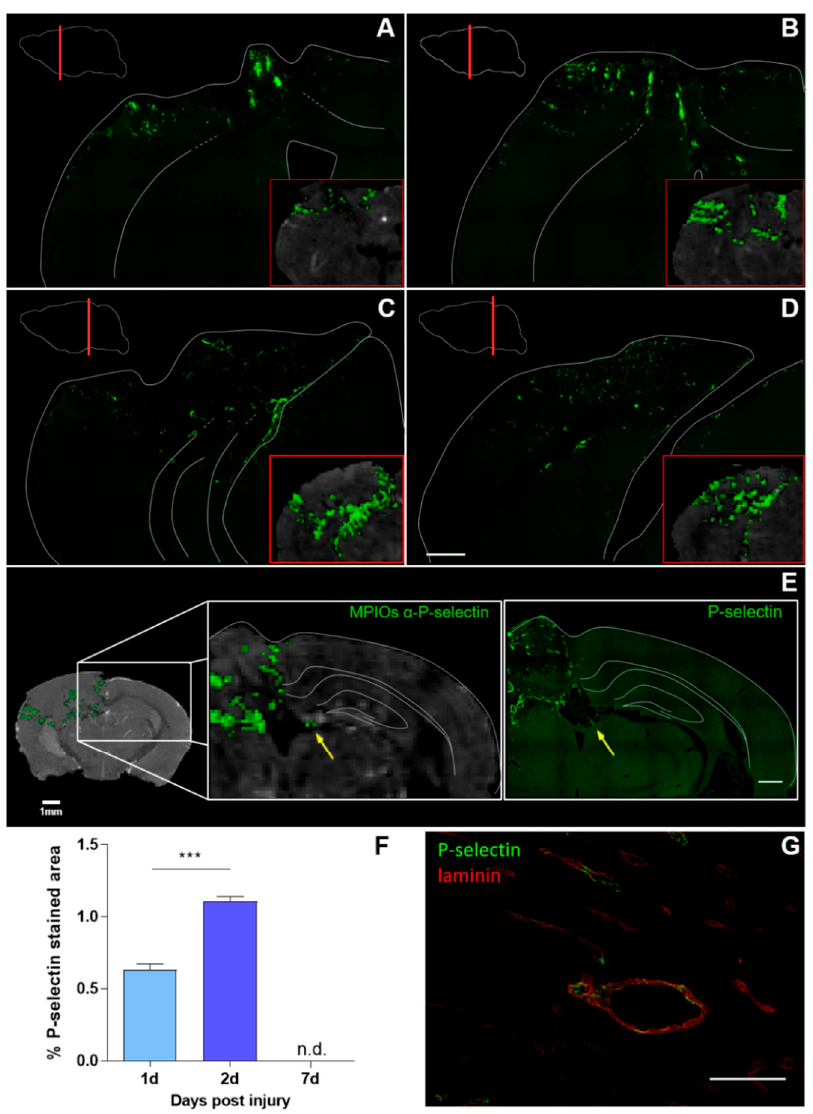
Figure 3. P-selectin signals by MRI and immunofluorescence. ( A – D ) Representative IF P-selectin stained coronal sections − 0.2, − 0.6, − 2.4 and 3.2 from bregma and corresponding MRI slices (insert as red boxes) two days post-injury. Scale bar 500 µ m. A sketch of the main structures of each brain slice was superimposed on the IF image to facilitate the reading. Data indicate a coherent spatial distribution of P-selectin signal with higher percentage of stained area detected by MRI than with IF. ( E ) Qualitative images showing correspondence between MPIOs- α -P-selectin marked volume assessed by MRI in contralateral hemisphere, and P-selectin IF. Here, the choroid plexus was the only structure ever positive for P-selectin (yellow arrows) by MRI and histological analysis. Scale bar 500 µ m ( F ) The percentage of the P-selectin stained area in the ipsilateral hemisphere was assessed 1, 2 and 7 days post-TBI. Data are mean + SEM, 3-4 / group; unpaired t -test, *** p < 0.001. ( G ) P-selectin (green) colocalizes with vessel (laminin in red). Scale bar 100 µ